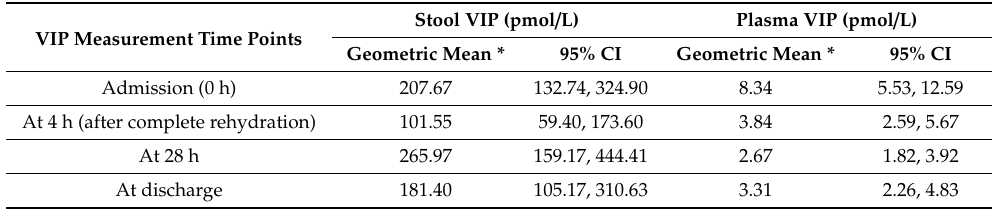
Table 2. Variations of stool and plasma VIP concentrations (pmol / L) over four timepoints before and after rehydration among cholera